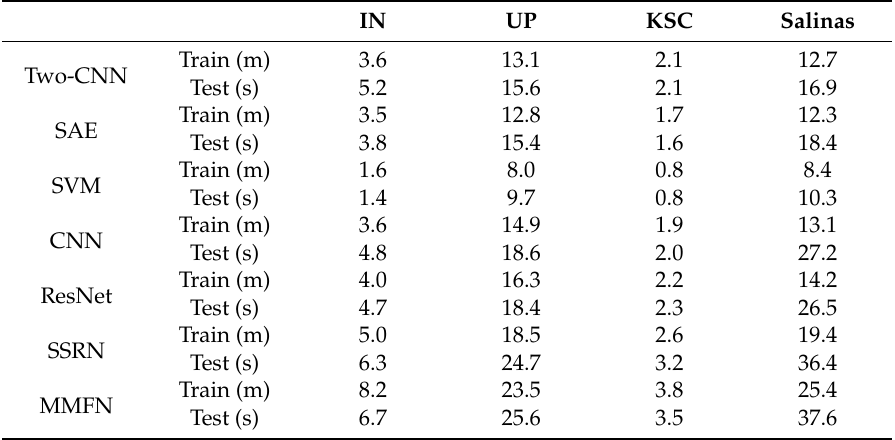
Table 13. Comparison of training and test time for each method on four data sets. IN UP KSC